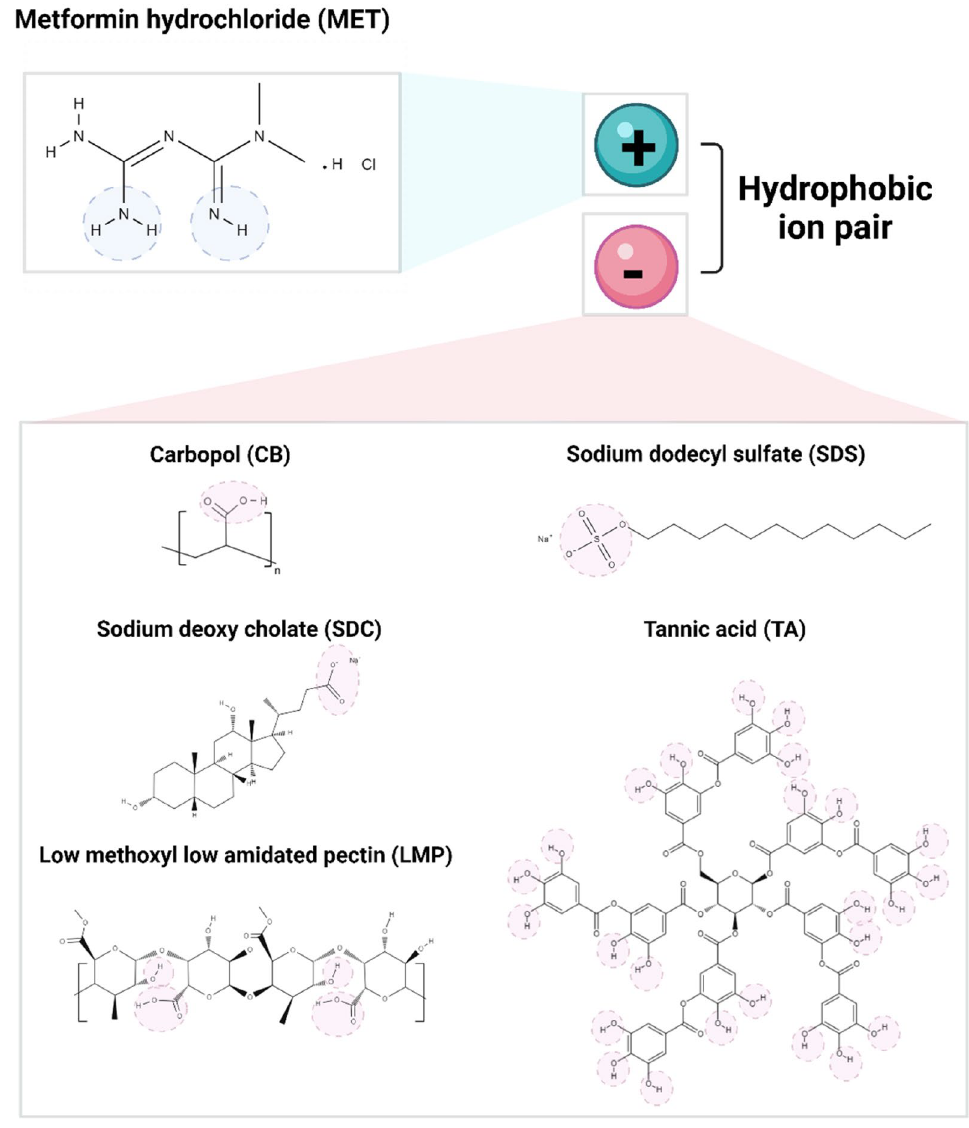
Figure 1. Chemical structures of metformin hydrochloride (MET) and different anionic ligands screened for hydrophobic ion-pairing (HIP). Charged moieties are indicated with